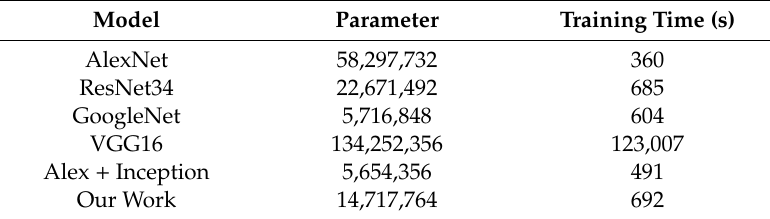
Table 4. Comparison of the training parameters and